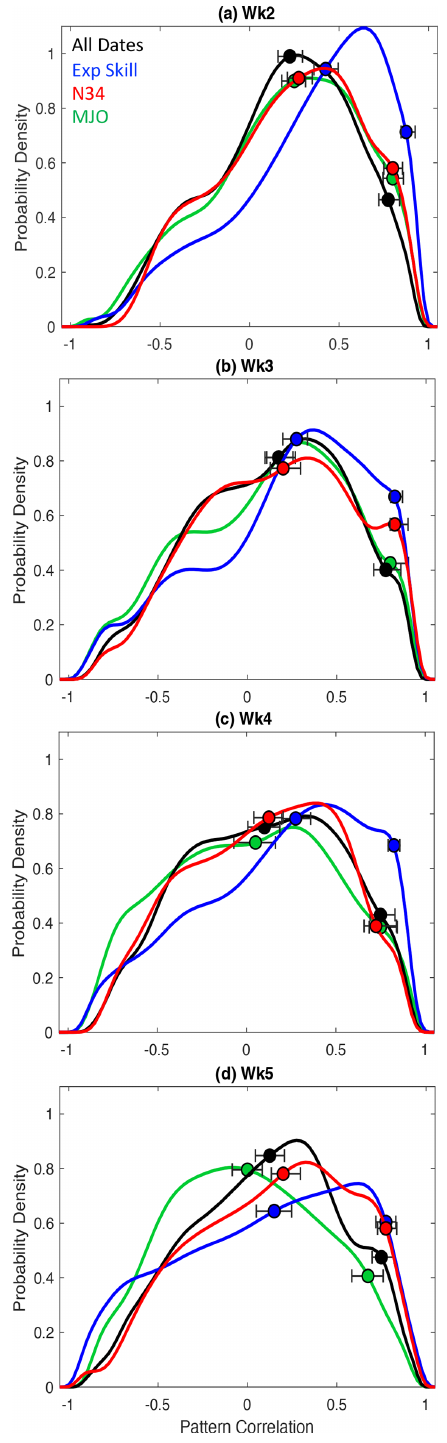
Figure 5. PDFs of the precipitation PCC for all forecasts (black lines) and the 20% of forecasts with the highest-expected-skill (blue), the highest-Niño3.4 (red), and the highest-RMM (green) ini- tializations. The bootstrapped confidence intervals for the median and 95th percentile of the distribution are shown with the